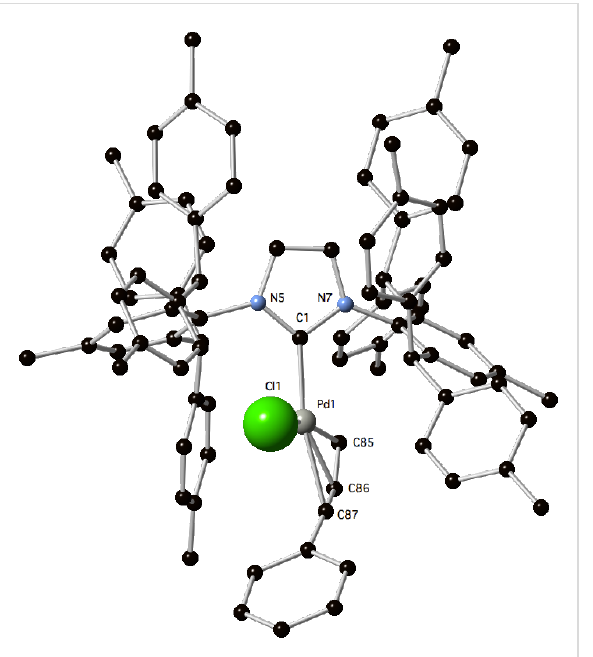
Figure 2: Molecular structure of 4 . H atoms were omitted for clarity. Selected bond lengths (Å) and angles (°): Pd1–C1 2.034(0), Pd1–Cl1